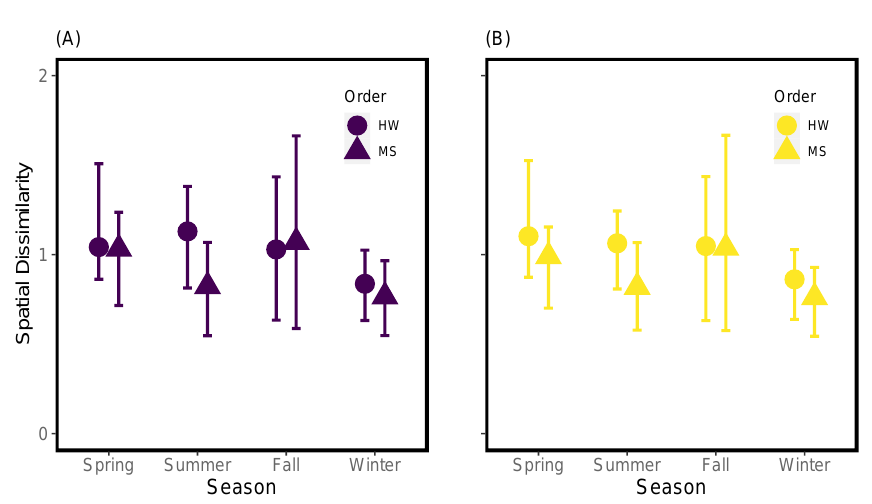
Figure 3 : Plots of spatial dissimilarity between paired restored and adjacent reaches. Estimates are reported for headwaters (HW, circles) and mainstems (MS, triangles); values from the full sites are reported in purple (A), while those from the revised sites are reported in yellow (B). Points represent mean ± 95% CI.